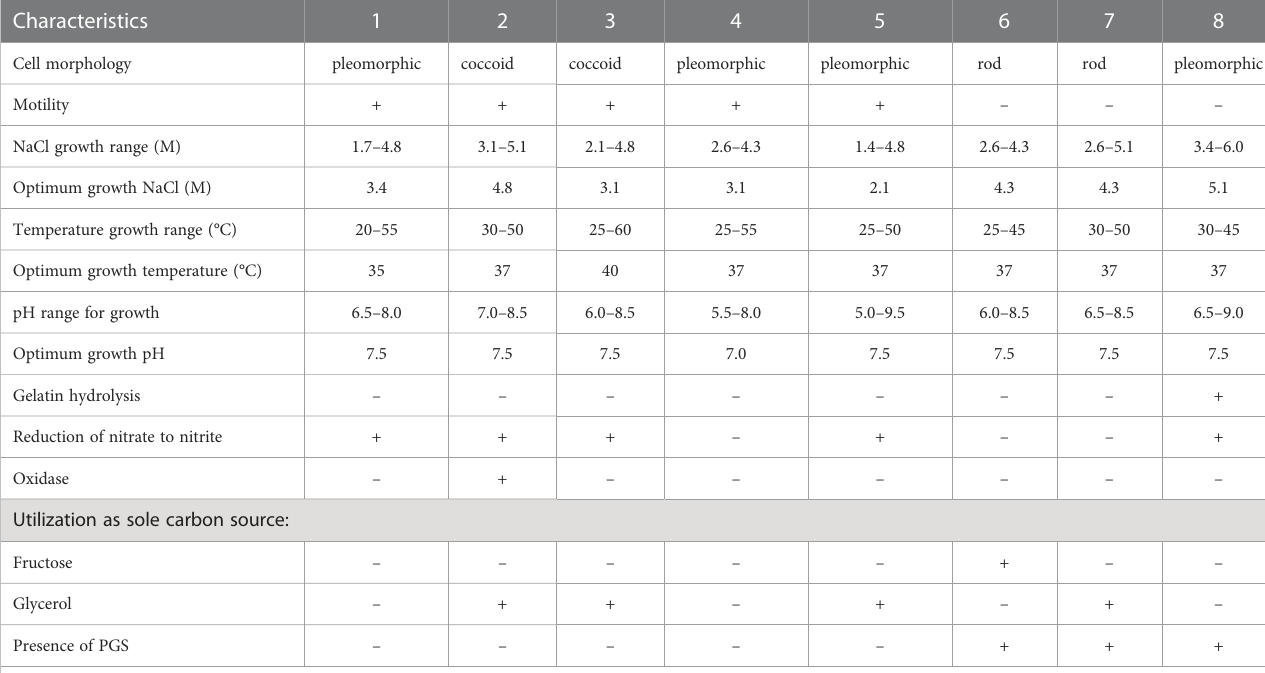
TABLE 1 Differential characteristics of strains BND22 T , ZY10 T , ZY41 T , ZY58 T and their closely related species within the family Haloarculaceae .